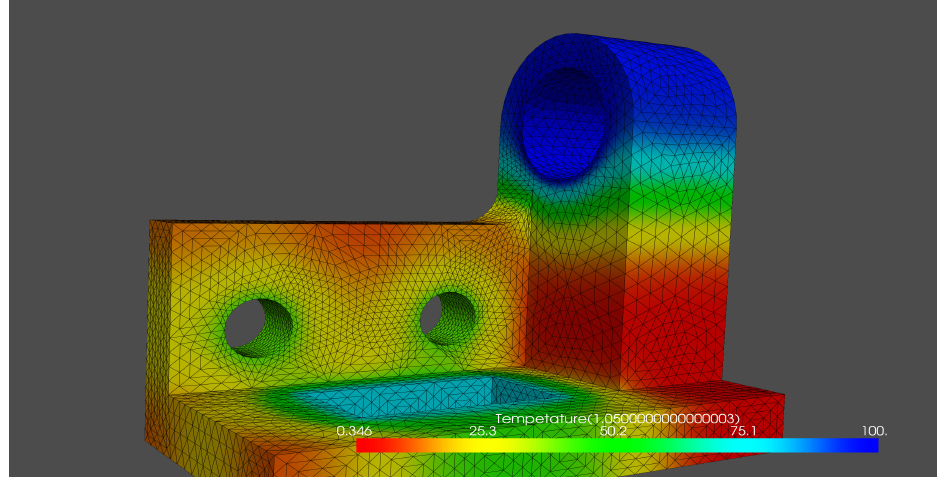
Figure 9. Temperature contour of a function space of order 1 at t = 1.05 s.